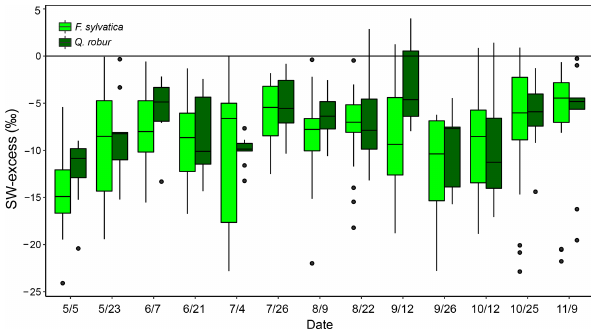
Figure 5. Temporal variations of SW-excess of F. sylvatica and Q. robur xylem samples over the 2017 growing season. Box size represents the interquartile range, the black line is the median, the whiskers indicate variability outside the upper and lower quartiles, and individual points are